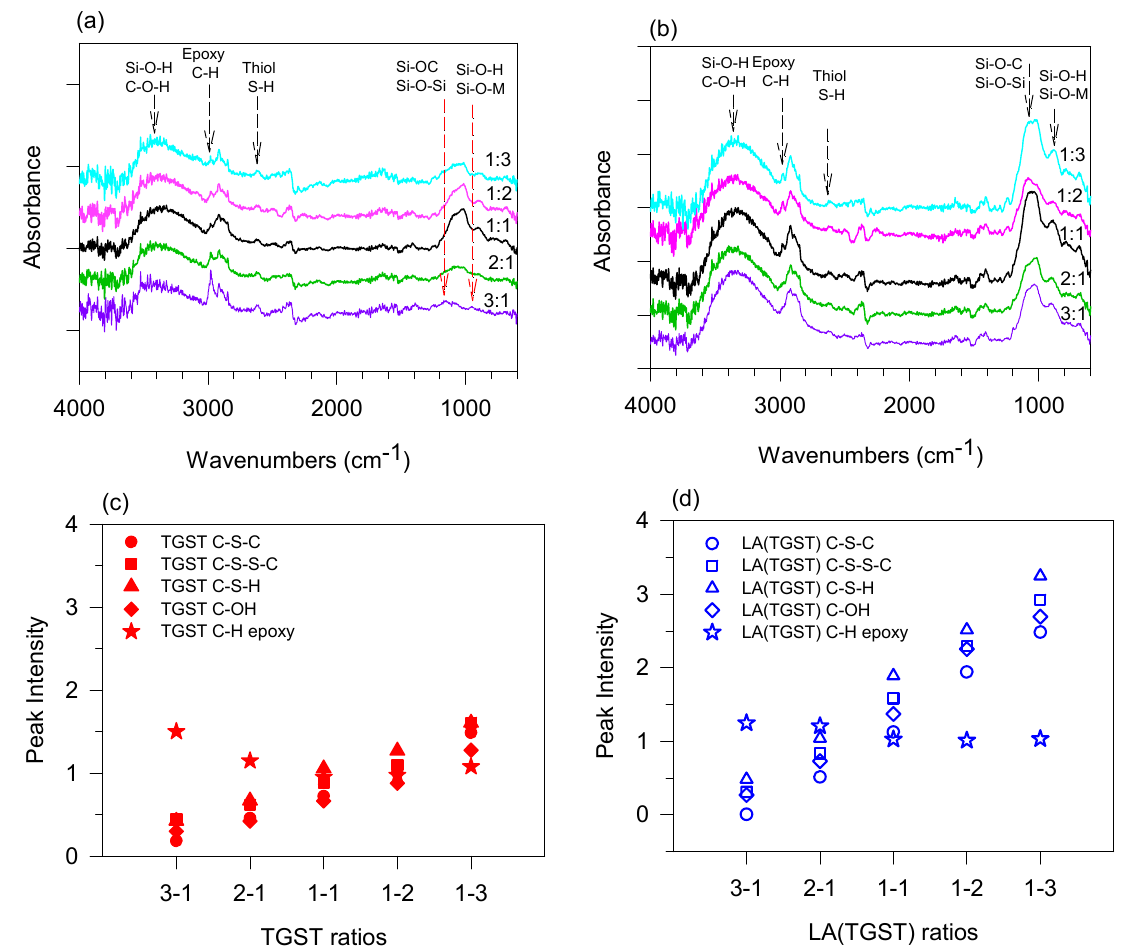
Figure 3. FTIR spectra showing the variation of epoxy and thiol peaks after reaction for ( a ) TGST and ( b ) LA(TGST) formulations. ( c , d ) indicate the extent of crosslinking shown by various intensities associated with the epoxy and thiol functional groups interaction with increasing TG:ST and LA(TG):LA(ST) ratios.